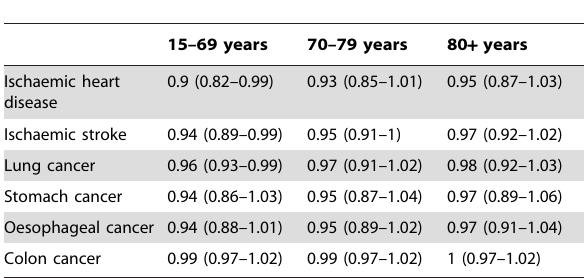
Table 2. Unit change in relative risk with an 80 gram per day increase in consumption of fruits and vegetables (approximately equivalent to one serve)